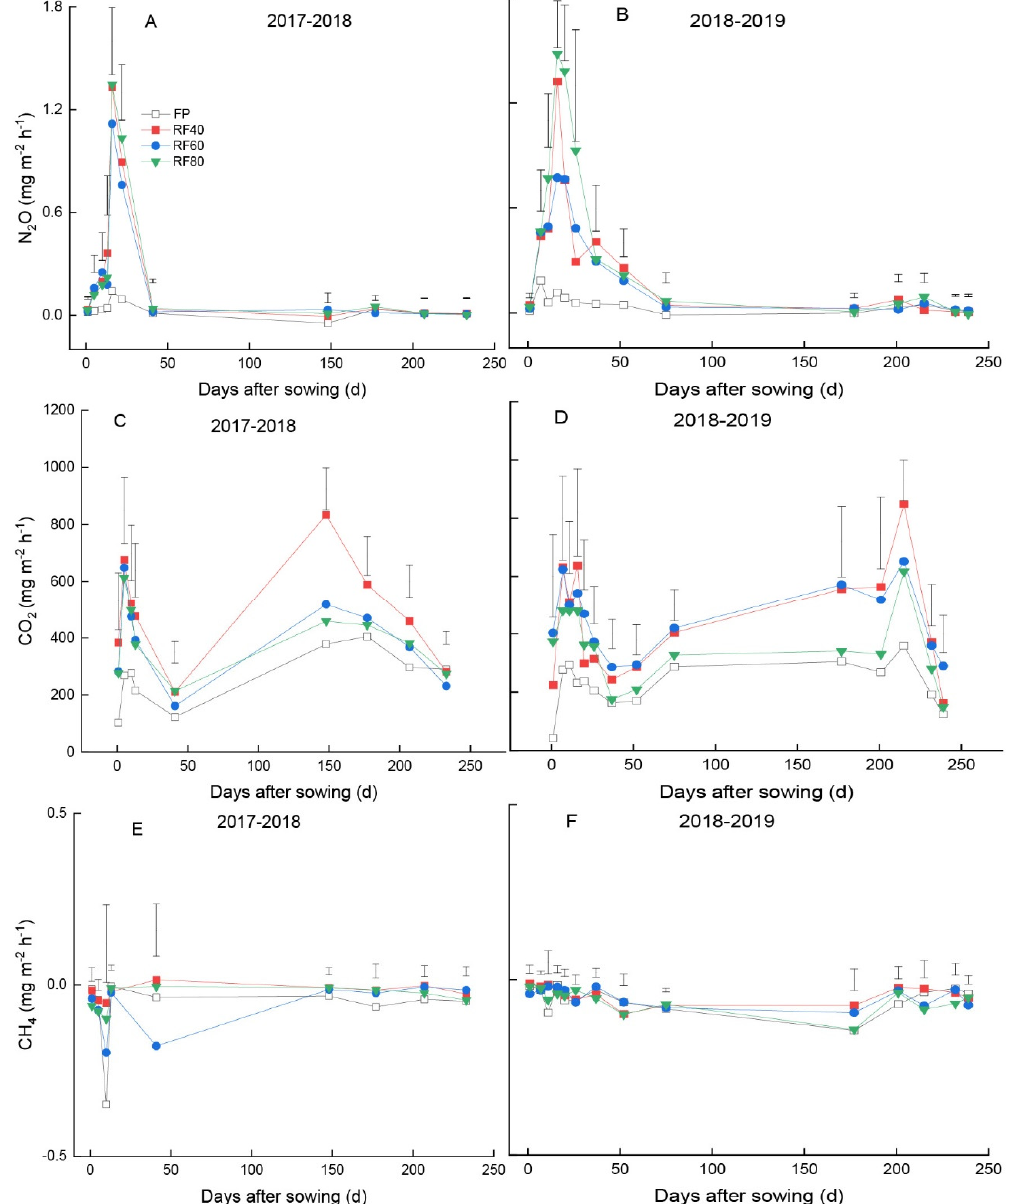
Figure 4. Dynamic variations of N 2 O ( A , B ), CO 2 ( C , D ), and CH 4 ( E , F ) fluxes from the field during winter wheat growing seasons in 2017–2019. Vertical bars represent the LSD values at p = 0.05 level.